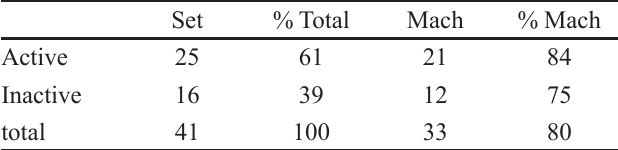
TABLE III - Kohonen obtained results for active and nactive sets with its respective mach and mach percentage Set %